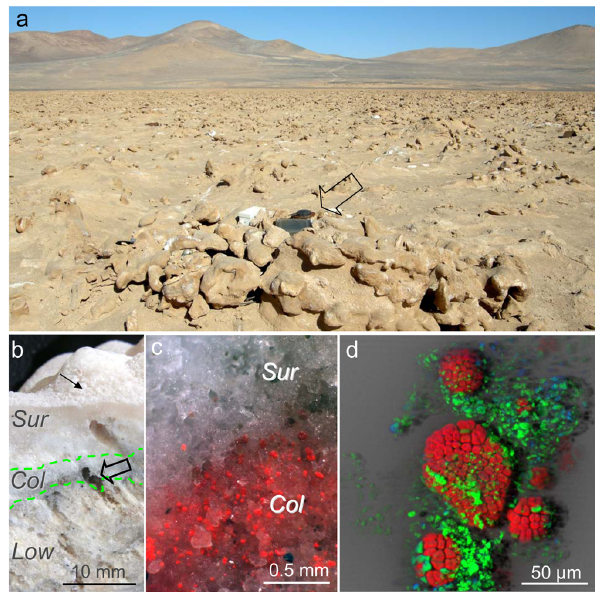
Fig. 1. Halite pinnacles and their endolithic microbial community in the Yungay region of the Atacama Desert. (a) Group of halite pinnacles with the microweather station in the foreground (open ar- row). (b) Fractured halite pinnacle with a non-colonized outer layer (Sur), colonized intermediate zone (Col) with larger pores (open arrow), and a non-colonized inner layer (Low). Note the halite ef- florescence on the pinnacle surface (black arrow), which indicates recent brine evaporation. (c) Fluorescence microscopy (FM) reveals the sharp boundary between the non-colonized outer layer and the colonized zone (red autofluorescence of cyanobacterial aggregates). (d) In situ 3-D FM-SIM image of cyanobacterial aggregates (red autofluorescence signal), and associated heterotrophic bacteria and archaea (SYBR Green stained DNA structures green